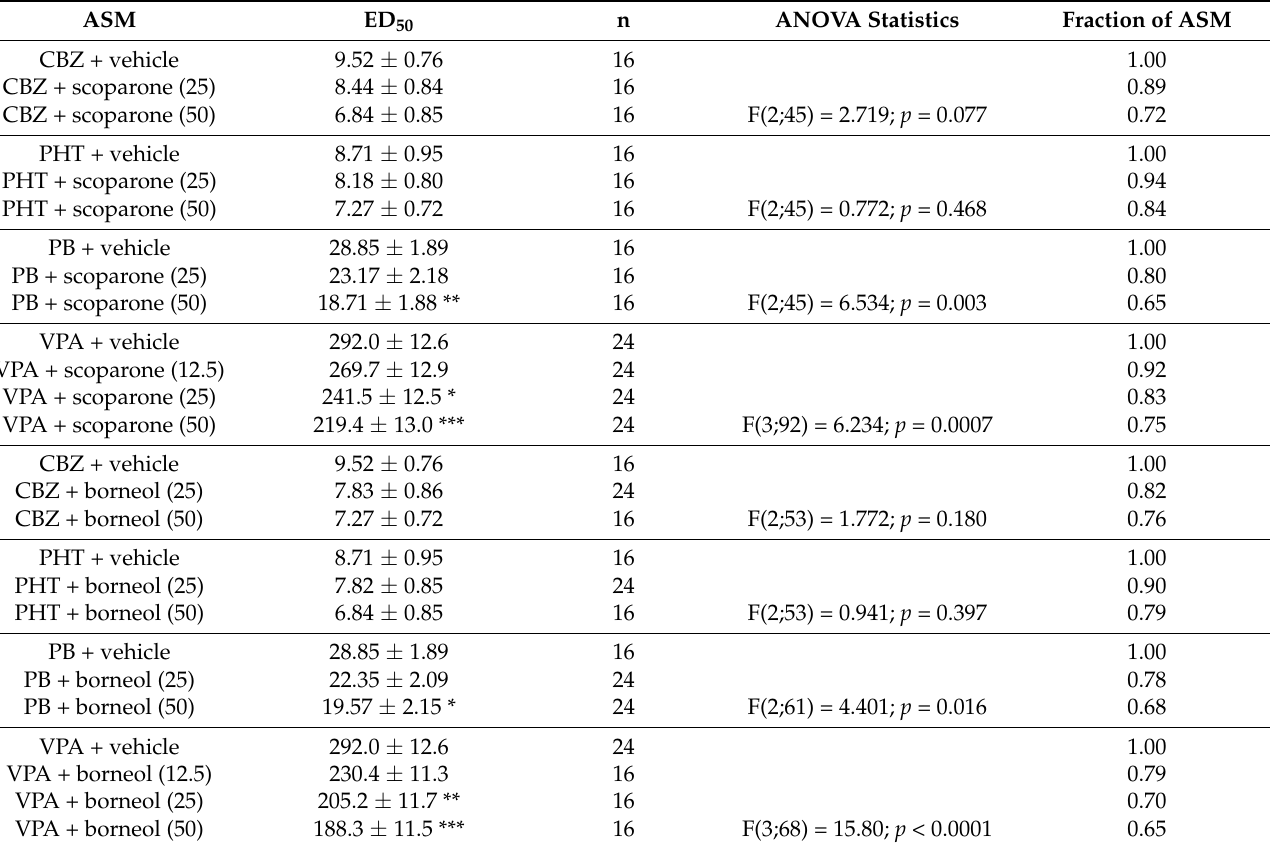
Table 1. Influence of scoparone and borneol on the anticonvulsant potency of four classic antiseizure medications (ASMs) in the mouse MES